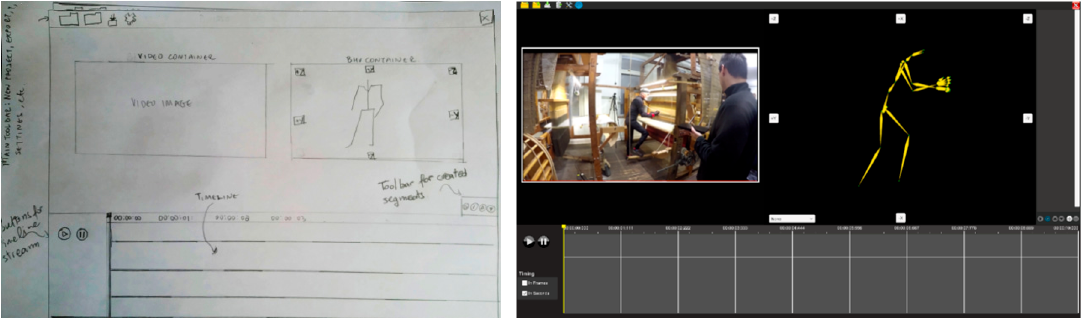
Figure 7. ( Left ): Paper prototype for AnimIO, ( Right ) AnimIO version 1.0.